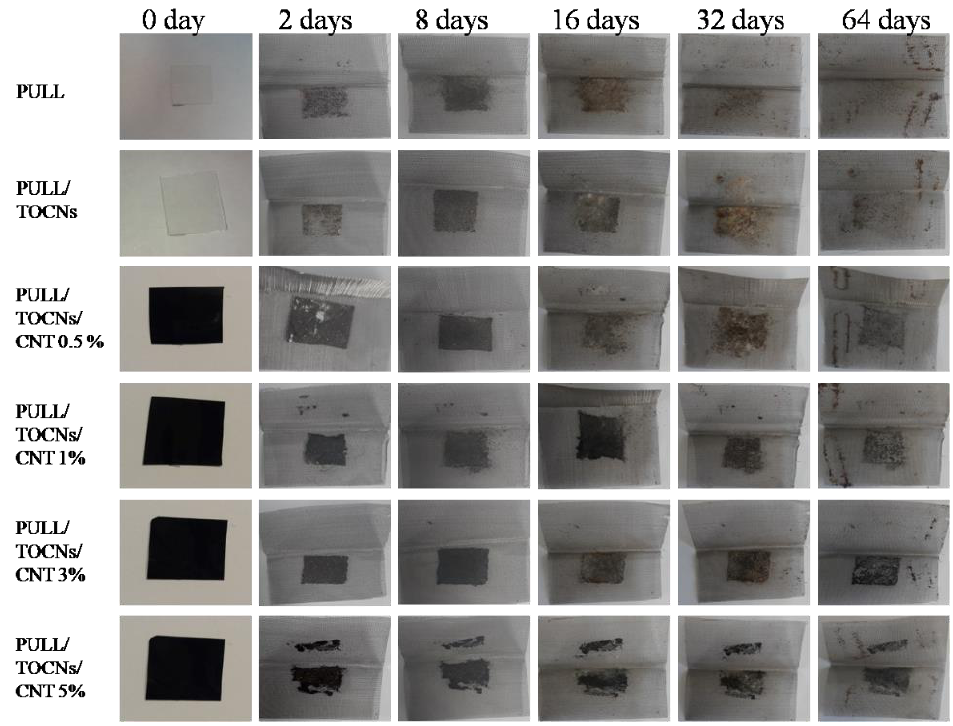
Figure 11. Macroscopic pictures of the biodegradation of different film samples in soil.